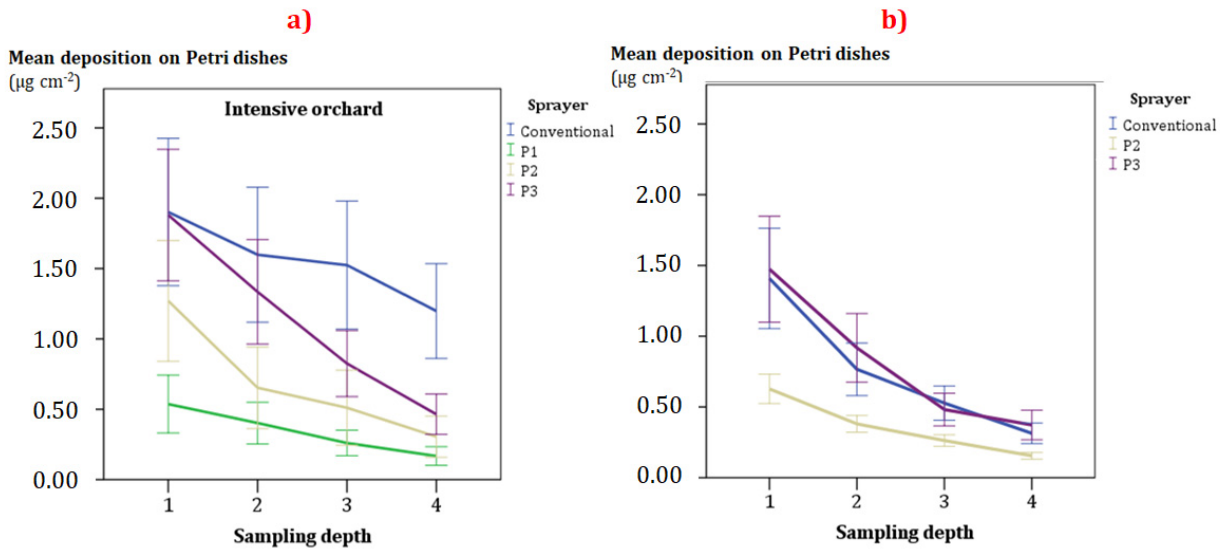
Figure 8. Mean deposition values on the Petri dishes per sampling depth (according to the scheme in Figure 5b, 1 is the minimum distance to the sprayed trees and 4 is the maximum one) in ( a ) the intensive orchard and ( b ) the traditional orchard. Whiskers represent the standard